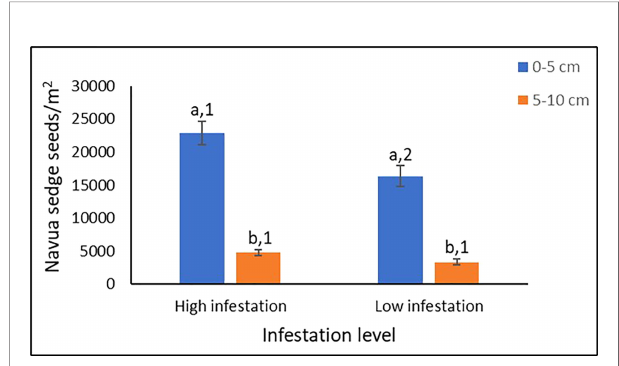
FIGURE 3 | Navua sedge seeds/m 2 present in the 0-5 cm and 5-10 cm soil pro fi le in high and low infestation plots. N= 4-6 plots per site; Data has been combined across all six sites. The same letters within each infestation level indicates no signi fi cant difference at p < 0.05. The same numbers within each soil layer indicates no signi fi cant difference at p <